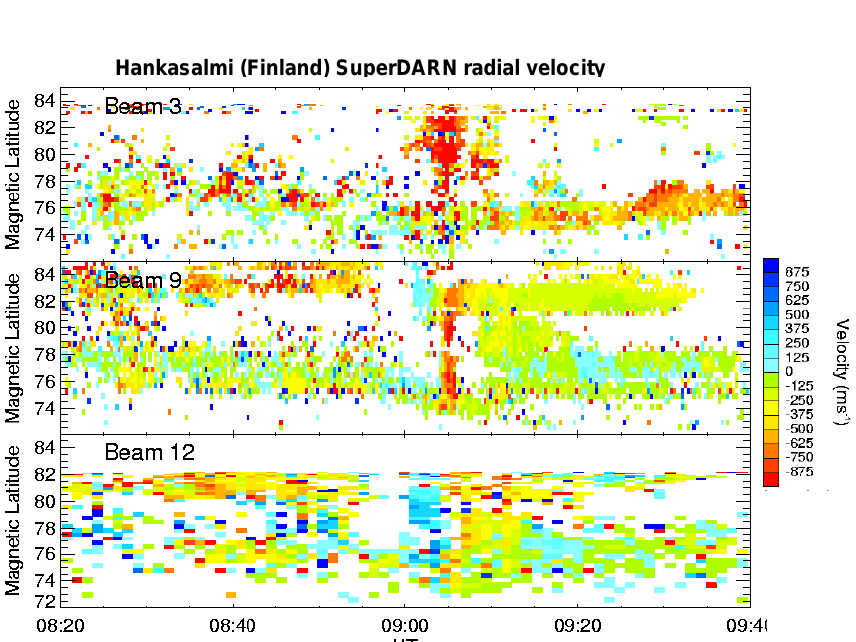
Fig. 4. Magnetometer data from the IMAGE north-south chain and from Hermanus (South Africa).